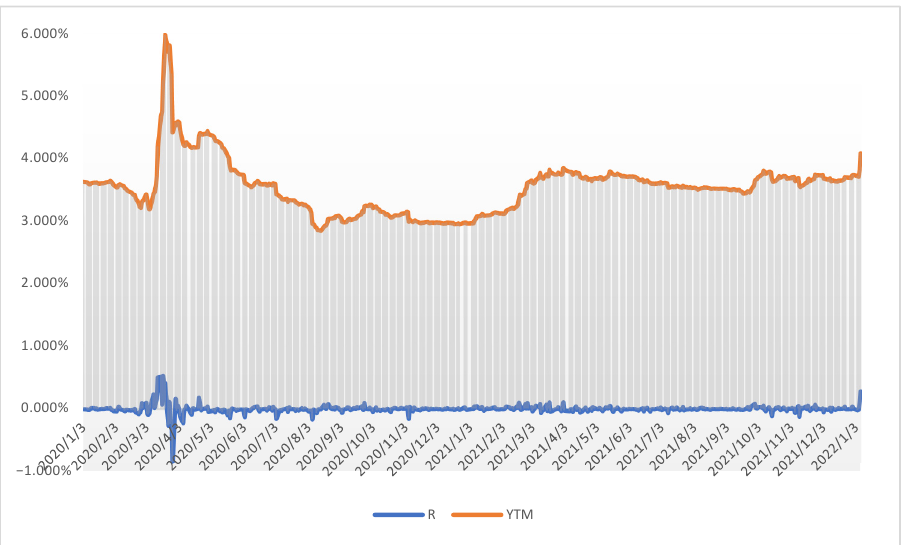
Figure 2. The volatility of the yield return and YTM of bond issue Kz15/45 from 2 January 2020 to 8 January 2022.